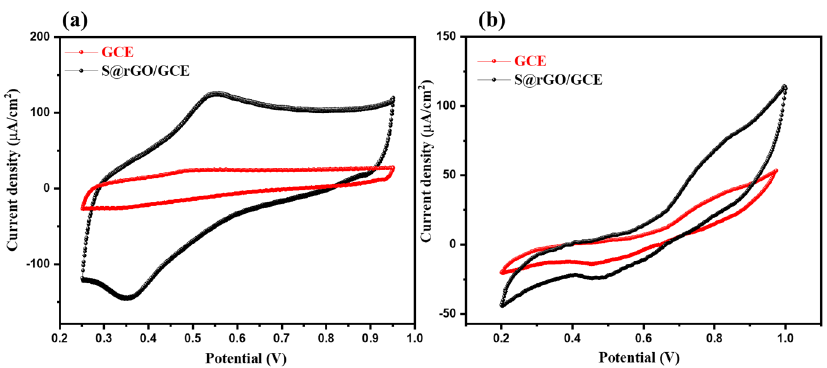
Figure 4. CV patterns of GCE and S@rGO/GCE in 91 µM ( a ) and 0 µM ( b ) acetaminophen in 0.1 M PBS of PH 7.0; scan rate = 50 mV/s.